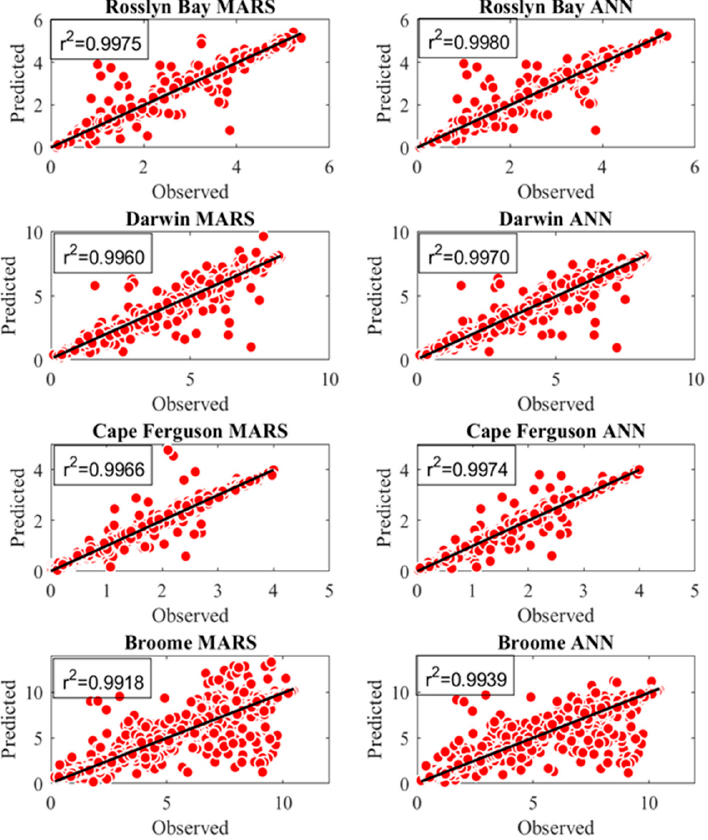
Figure 10. Scatterplot shows the line of best fit of the MARS and ANN